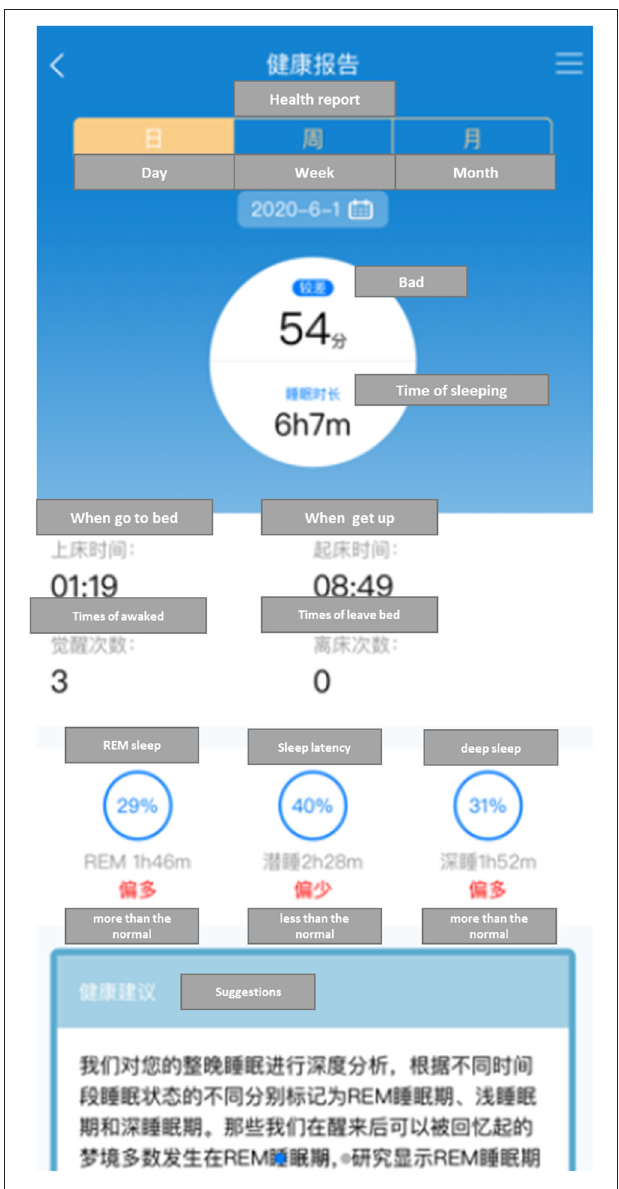
FIGURE 2 | The sleep monitoring and reporting interface of Smart Aged Care